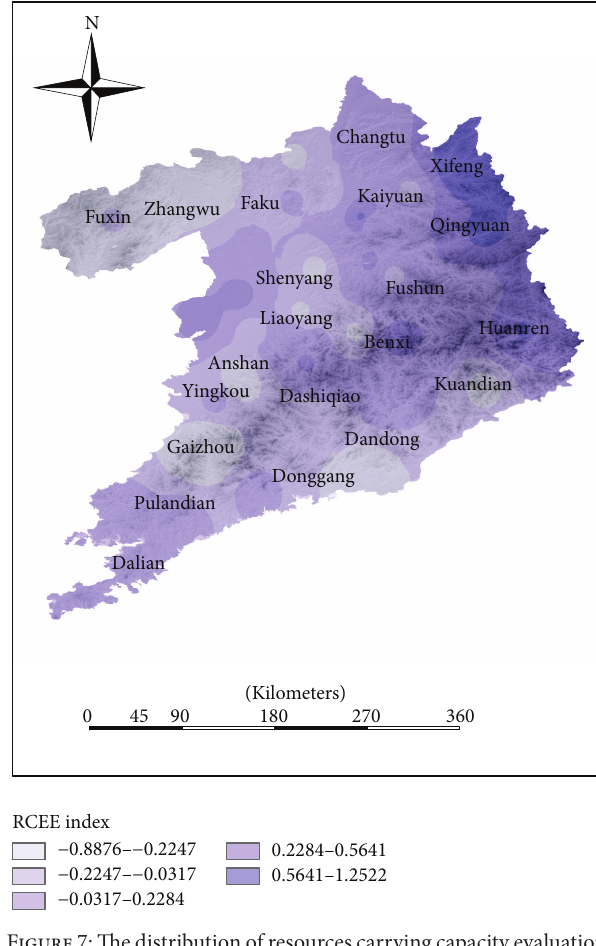
Figure 6: The distribution of human living environmental evalua- tion (HLEE) index in Shenyang-Dalian urban agglomeration.